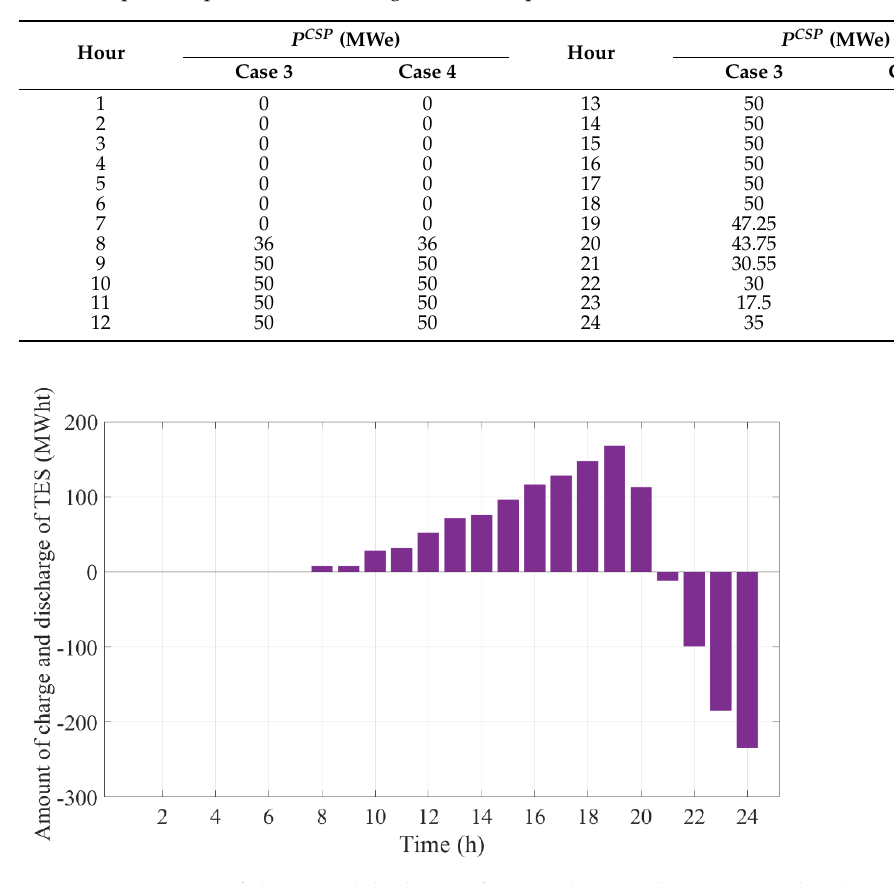
Figure 13. Amounts of charge and discharge of TES in the CSP plant associated with case 4. 4. Conclusions In this paper, the day-ahead scheduling of a price-taker GENCO equipped with ther- mal, CAES, and CSP units was presented. The proposed mathematical model determines the optimal bidding strategy in the DAM for the GENCO, whose objective is to maximize the total profit achieved through participation in the energy market. The proposed frame- work, formulated based on the MILP format, was effectively solved by employing the CPLEX solver under the GAMS environment. In this paper, the effects and valuable ben- efits of the CAES and CSP units on the optimal solution of the PBUC problem were stud- ied in four cases. The simulation results revealed that the CAES technology enables the GENCO to take advantage of favorable price deviations through opportunistic measures and to potentially attain higher profits. These storage facilities provide an appealing op- portunity for GENCOs to purchase electrical energy over off-peak hours to be retained in the form of compressed air and to sell the stored energy during peak periods when the prices in the pool market are significantly higher. In addition, the numerical analysis demonstrates that the CSP plant is an appropriate tool to reduce the need to operate costly thermal power plants by supplying electricity over the periods when the solar resource is available. Furthermore, it has been shown that using the TES system enhances the dis- patchability of the CSP unit through storing the thermal energy provided by the SF over